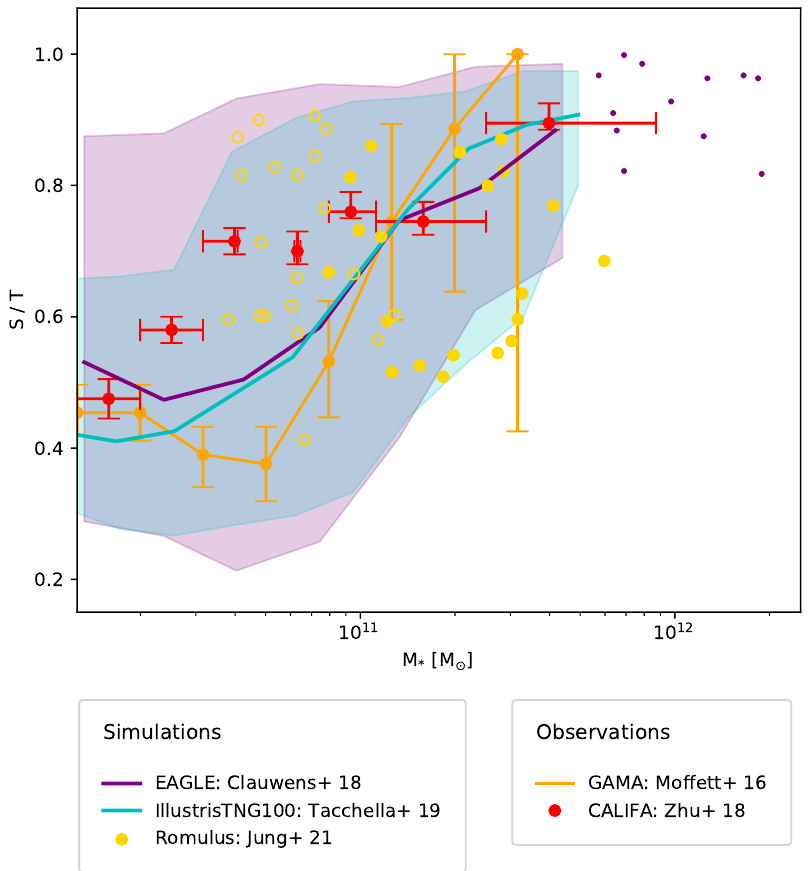
Figure 10. Figure adapted from Jung et al. [73]: The z = 0 spheroidal-to-total ( S / T ) for central galaxies in simulated galaxy groups and clusters from three simulations (ROMULUS, TNG100, and EAGLE), juxtaposed against results from two observational studies. The yellow filled and open circles show the ROMULUS kinematically derived results. (As in previous two figures, filled circles correspond to systems we identify as groups and clusters.) The cyan and purple curves show the median kinematically derived S / T results for TNG100 [244] and EAGLE [238], respectively. The purple shaded region indicates the 10–90% range while the cyan shaded region spans the 16%–84% range. The ROMULUS and TNG100 S / T are computed using the same criterion while the EAGLE results are based on a slightly different criterion. The two criteria, however, give very similar results. Of the two observational results shown, the CALIFA data are kinematically derived [275] while the GAMA results are based on photometry [13]. The two approaches are not equivalent. We discuss this further in the text. The simulation results should, in the first instance, be compared to the CALIFA